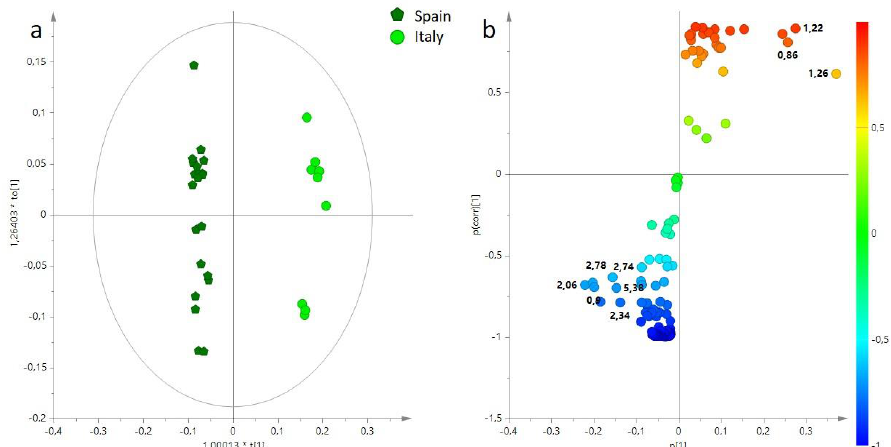
Figure 3. ( a ) OPLS-DA t[1]/to[1] PCA score plot performed on major components (BUCKET-1) of Arbequina EVOOs samples obtained from Spain and Italy, ( b ) S-plot for the OPLS-DA model colored according to the correlation-scaled loading vector (p(corr)). The variables indicated the chemical shift value (ppm) in the 1 H NMR spectrum.